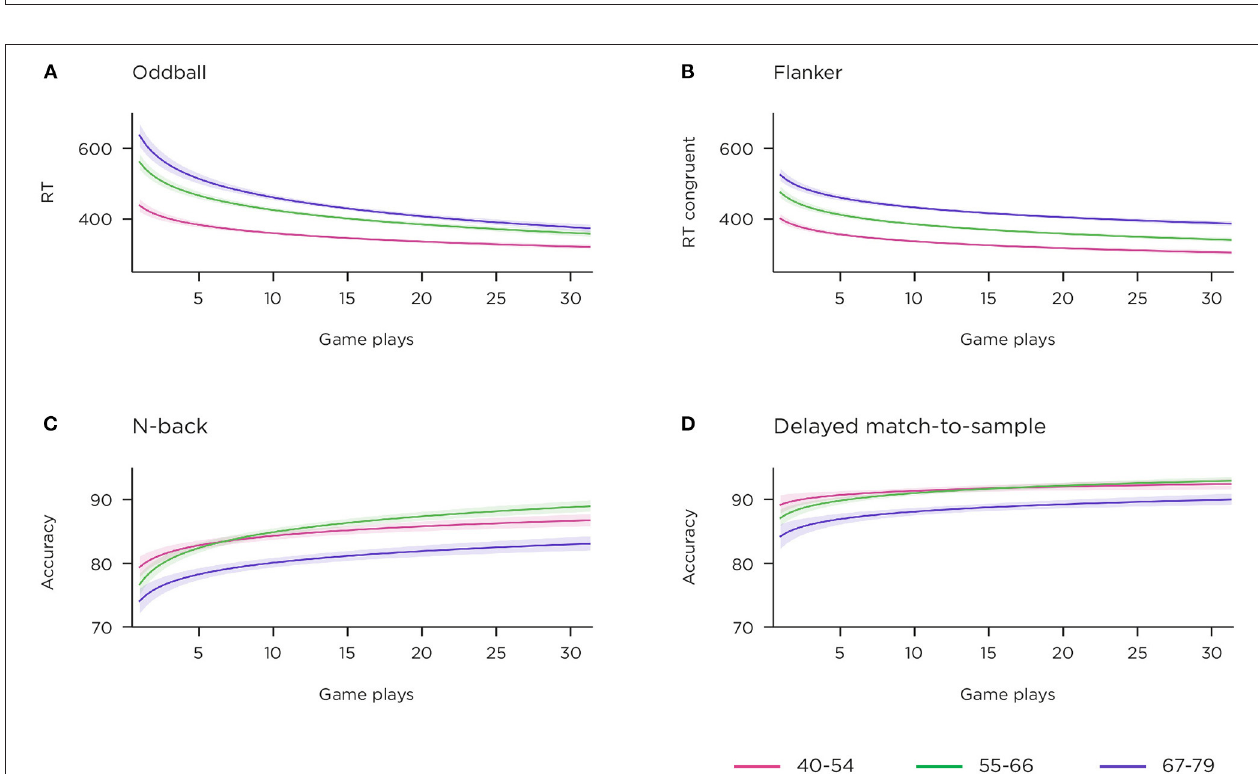
FIGURE 5 | Percentage of time each of 16 channels recorded non-saturated data, shown across age groups.